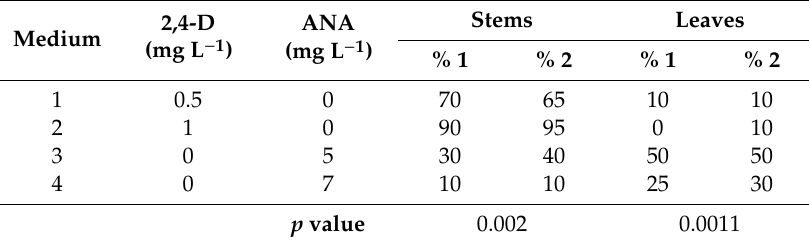
Table 1. (*). Percentage of embryogenic callus formation of Solanum betaceum